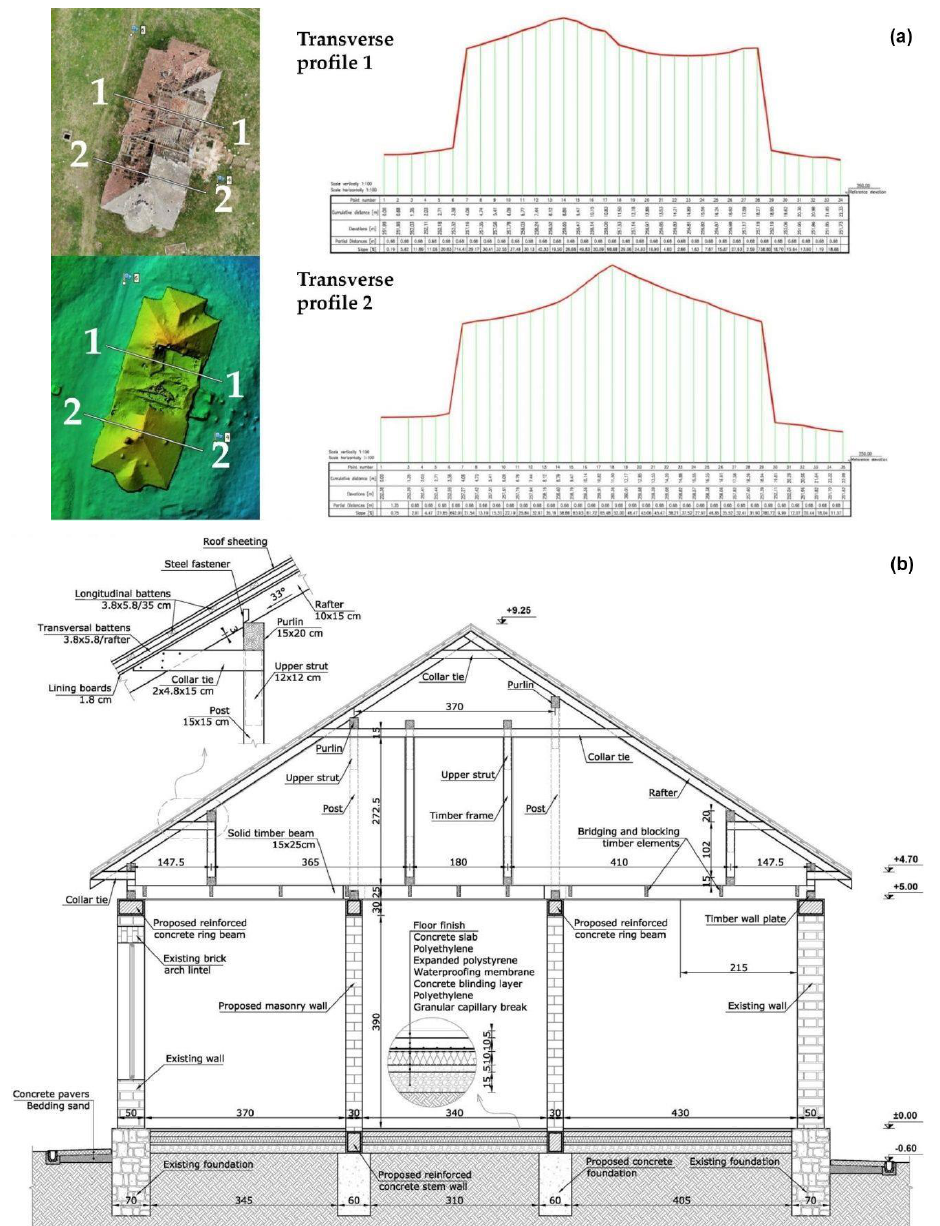
Figure 13. ( a ) Extracting metric data from transverse profiles; ( b ) Envisioned section.